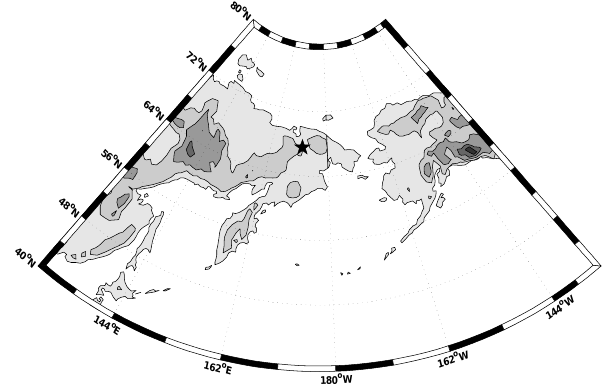
Fig. 1. Location of Lake El’gygytgyn (black star) in NE